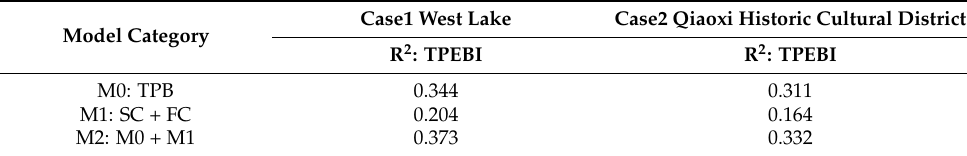
Table 6. Model comparison test